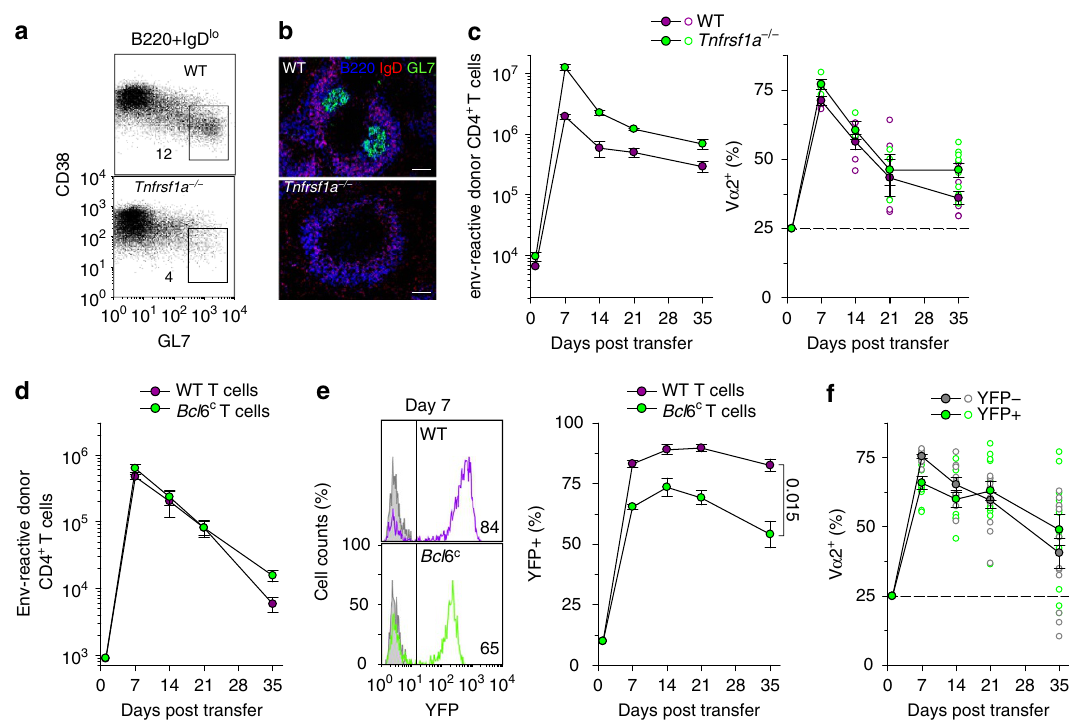
Figure 5 | Clonal replacement in virus-specific CD4 þ T cells independently of Bcl6-dependent Tfh differentiation or germinal center reaction. ( a ) Frequency of germinal center-phenotype (CD38 lo GL7 hi ) cells in CD19 þ IgD lo splenic B cells 35 days after FV infection of WT or Tnfrsf1a (cid:2) / (cid:2) mice ( n ¼ 3). ( b ) Germinal center (B220 þ IgD (cid:2) GL7 þ ) presence in the spleen of the same mice in a . The scale bar is 250 m m. ( c ) Absolute numbers (left) and V a composition (right) of env-reactive donor EF4.1 CD4 þ Tcells in the spleens of WTor Tnfrsf1a (cid:2) / (cid:2) recipient mice after adoptive T-cell transfer and FV infection ( n ¼ 3–9 mice per time point). ( d ) Absolute numbers of WT or Bcl6-conditional ( Bcl6 c ) env-reactive donor EF4.1 CD4 þ T cells, additionally carrying the Tnfrsf4 Cre and Gt(ROSA)26Sor YFP alleles, in the spleens of recipient mice after adoptive T-cell transfer and FV infection ( n ¼ 3–9 mice per time point). ( e ) YFP expression on day 7 (left) and frequency of YFP þ cells over time (right) in the same env-reactive donor EF4.1 CD4 þ Tcells as in d . ( f ) V a 2 frequency in YFP þ and YFP (cid:2) Bcl6-conditional env-reactive donor EF4.1 CD4 þ T cells as in d . In c – f , closed symbols are the means ( ± s.e.m.); open symbols are individual